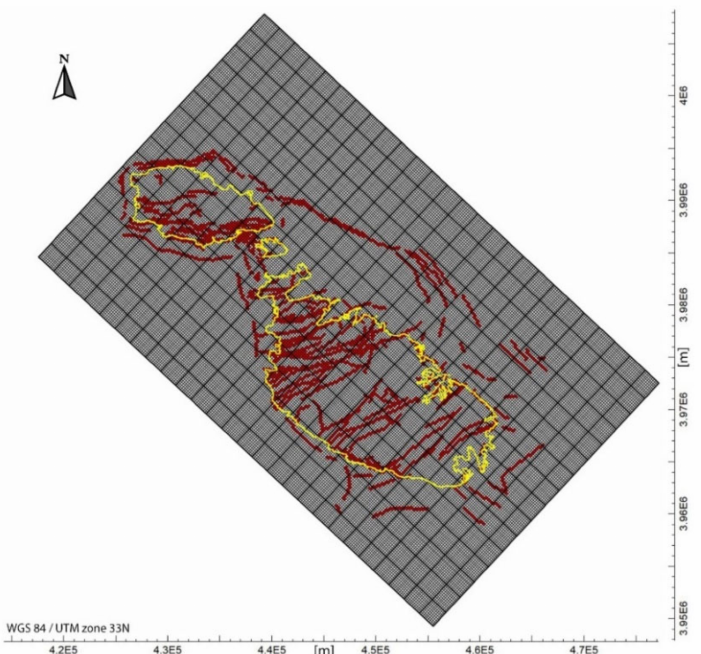
Figure 3. Faults system recreated within the model domain (red filled cells) and islands shoreline (yellow